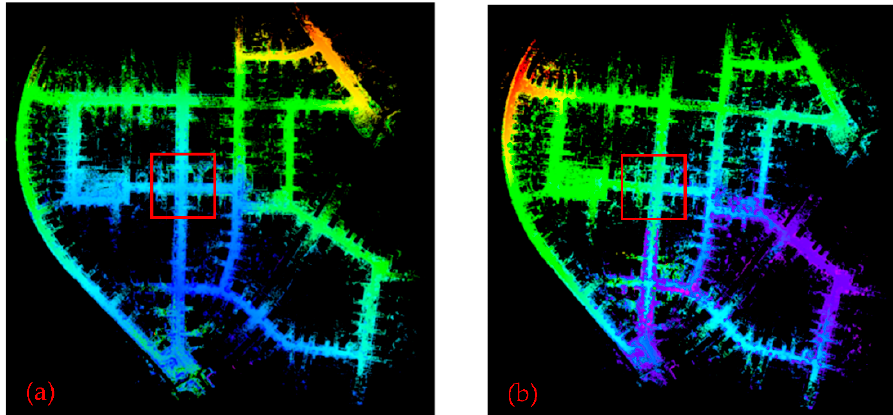
Figure 5. Point cloud map constructed by two algorithms using KITTI dataset 00 sequence point cloud data. ( a ) By LeGO-LOAM; ( b ) by Lego-Loam-SC.